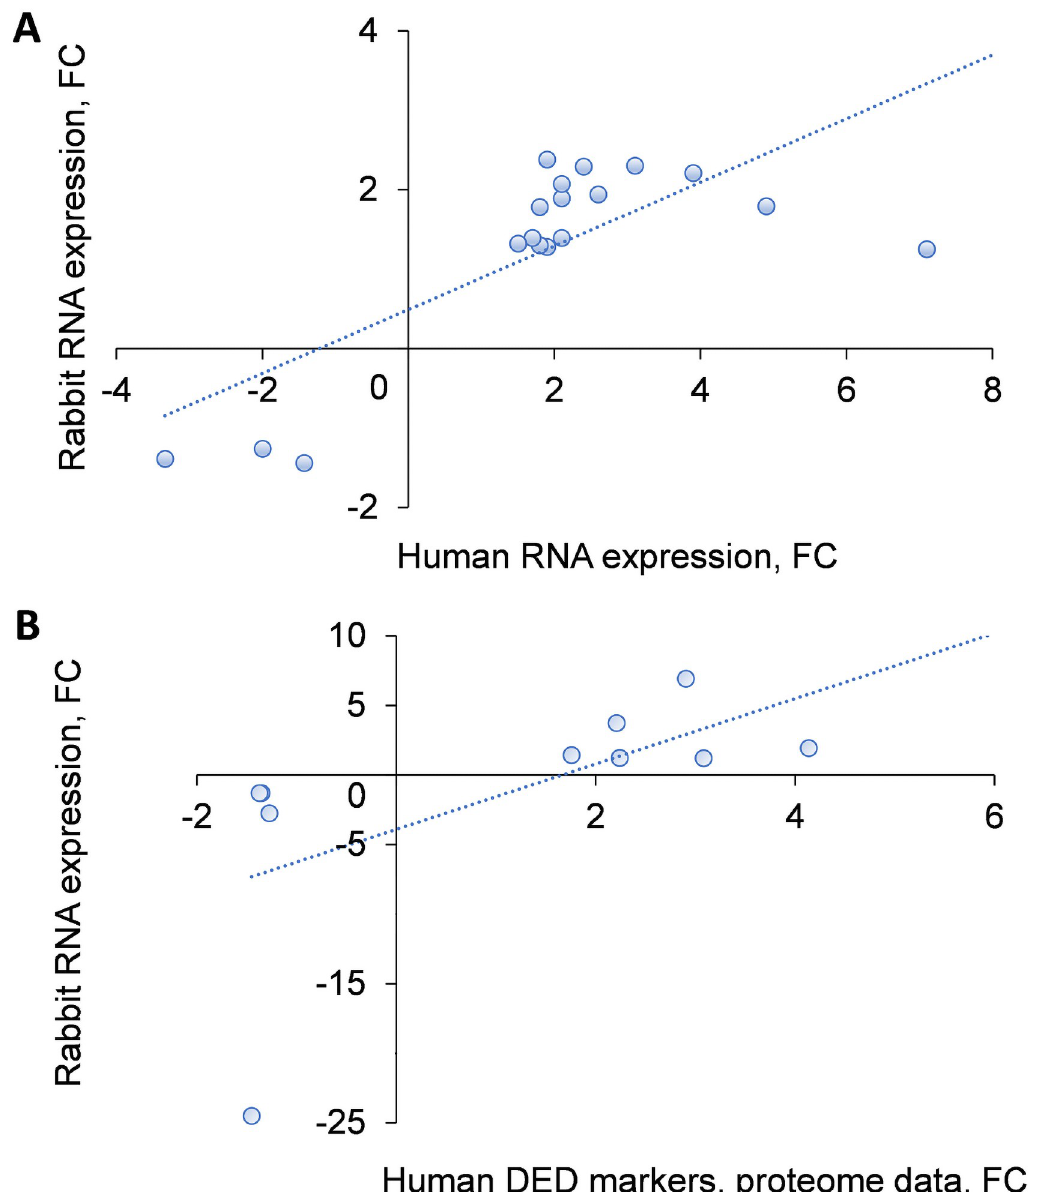
Fig 6. Correlation of gene expression between Sjogren syndrome and rabbits with DED. A . Gene expression levels (fold change, FC) in rabbits with DED were correlated with that in DED patients with Sjogren’s syndrome (FC � 1.3 up- or down- regulated, p-value < 0.001, n = 18). PCC R = 0.756, p < 0.001. B. Similar correlation between rabbit transcripts and human DED protein markers included in this analysis (FC � 1.3, p-value < 0.001, n = 9) was found (R = 0.662, p < 0.05), as in